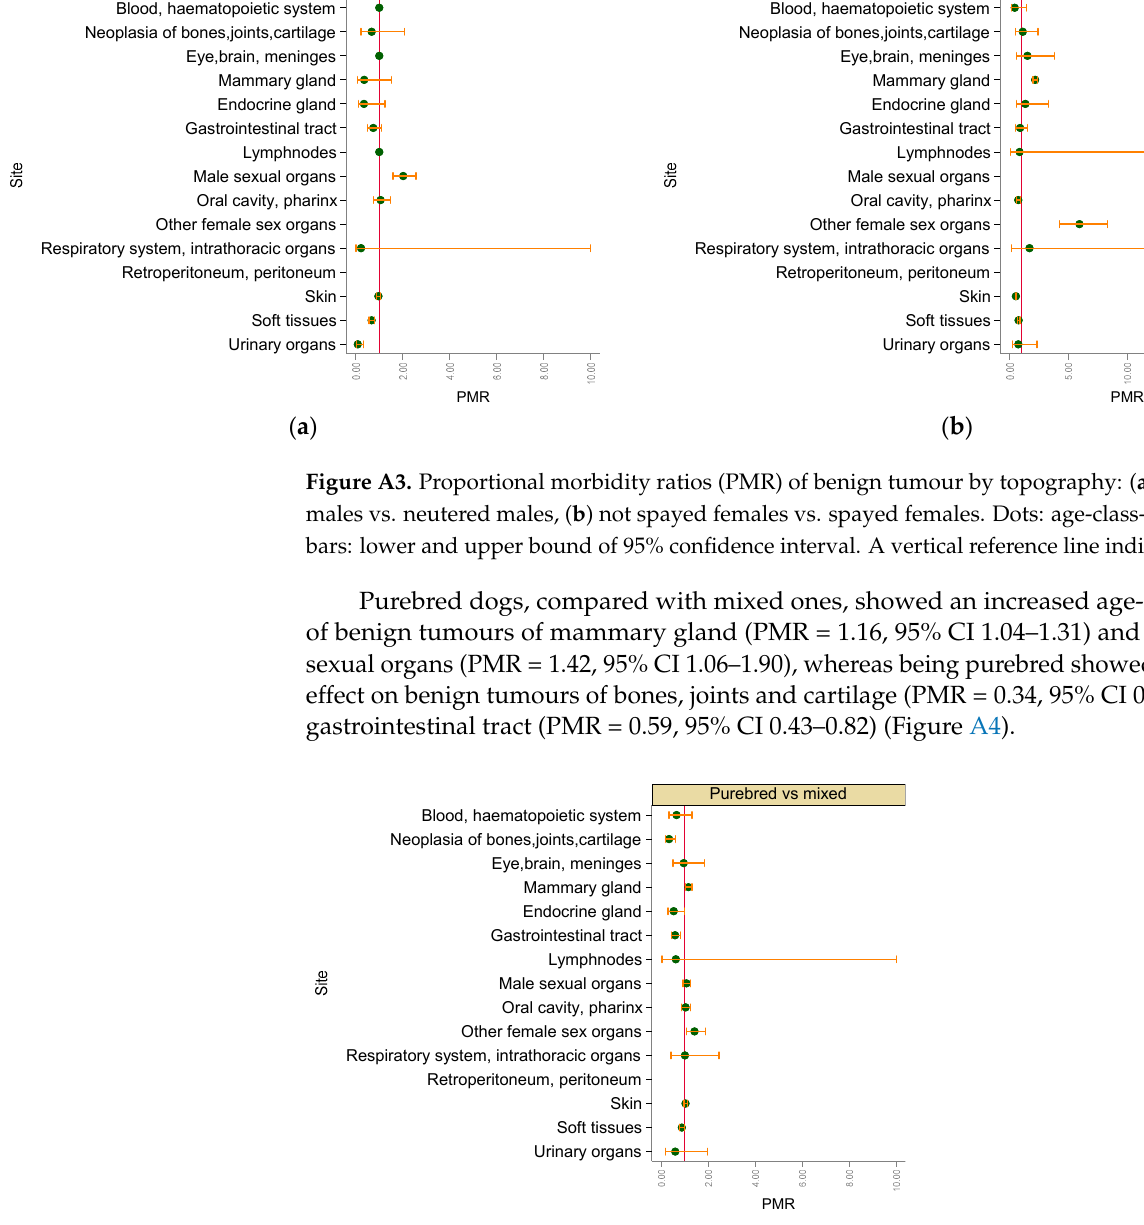
Figure A4. Proportional morbidity ratios (PMR) of benign tumours by topography comparing pure- bred and mixed dogs. Dots: age-class-adjusted PMR, bars: lower and upper bound of 95% confi- dence interval. A vertical reference line indicates PMR = 1.